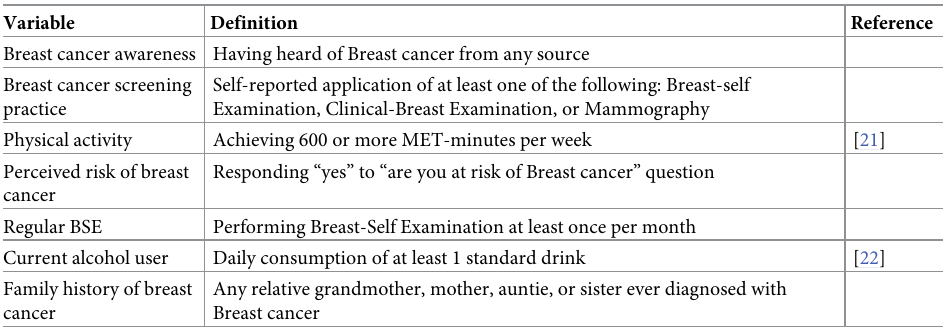
Table 1. Definitions of key study variables